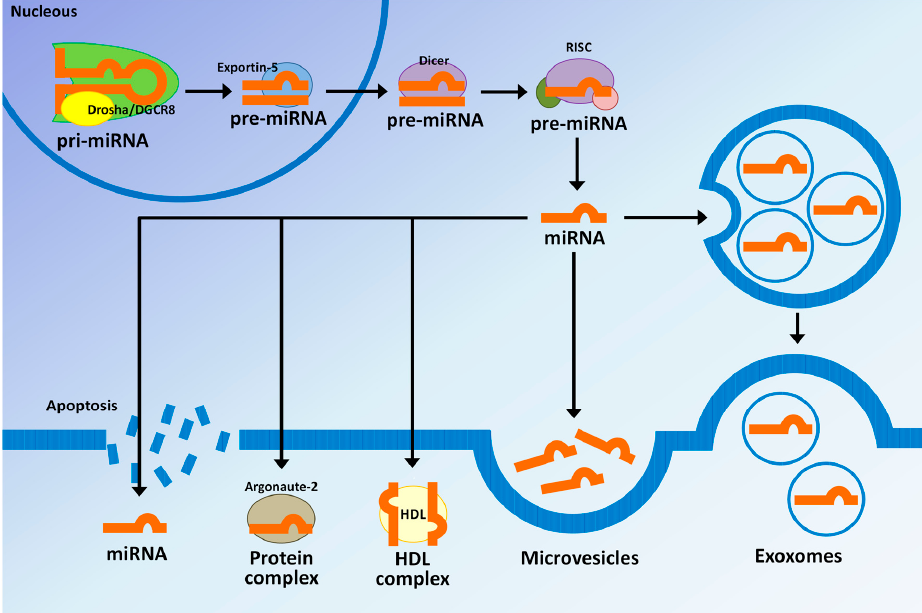
Figure 1. Origin mechanism of circulating microRNAs. MicroRNAs are exported from cells into circulation by free vesicles (active secretion via exosomes and microvesicles) and are associated with ribonucleoproteins, particularly with Argonaute (AGO) proteins. miRNAs have also been found in apoptotic bodies and associated with complexes with high density lipoprotein (HDL).